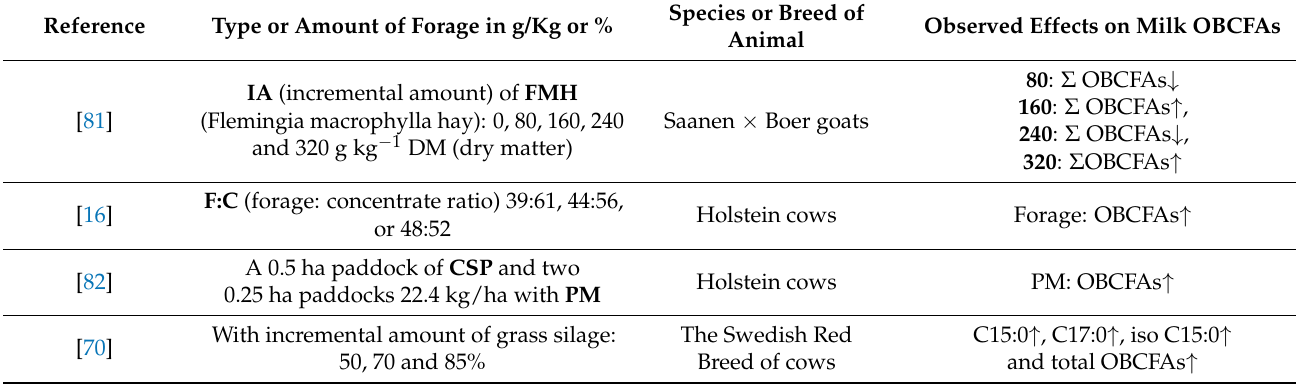
Table 3. Summary of the effects of proportion, type of forage, and forage-to-concentrate ratio on milk OBCFAs in ruminants.